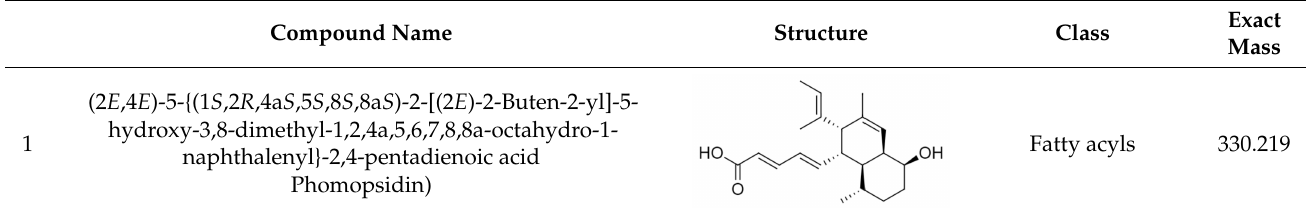
Table 3. Tentative identification of secondary metabolites from E. cavolini organic extract by using